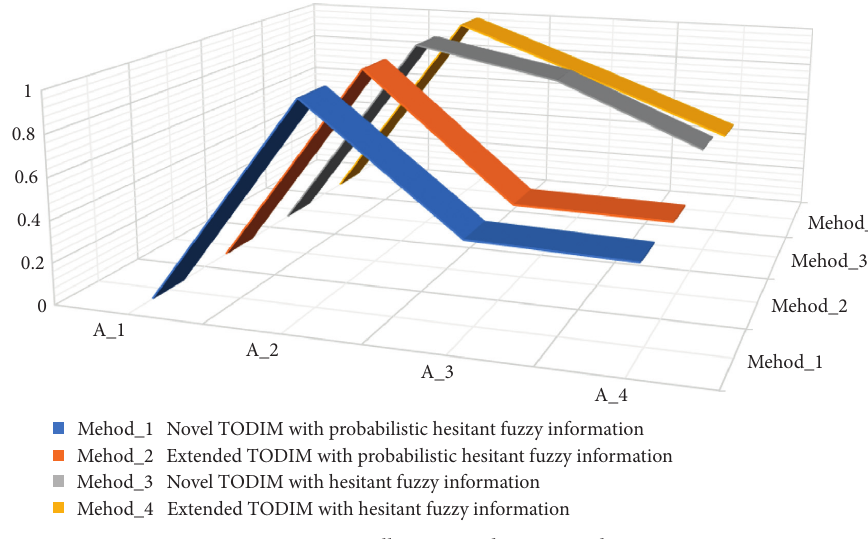
Figure 1: Overall prospect dominance degrees. Table 19: The positive ideal solution and negative ideal solution.